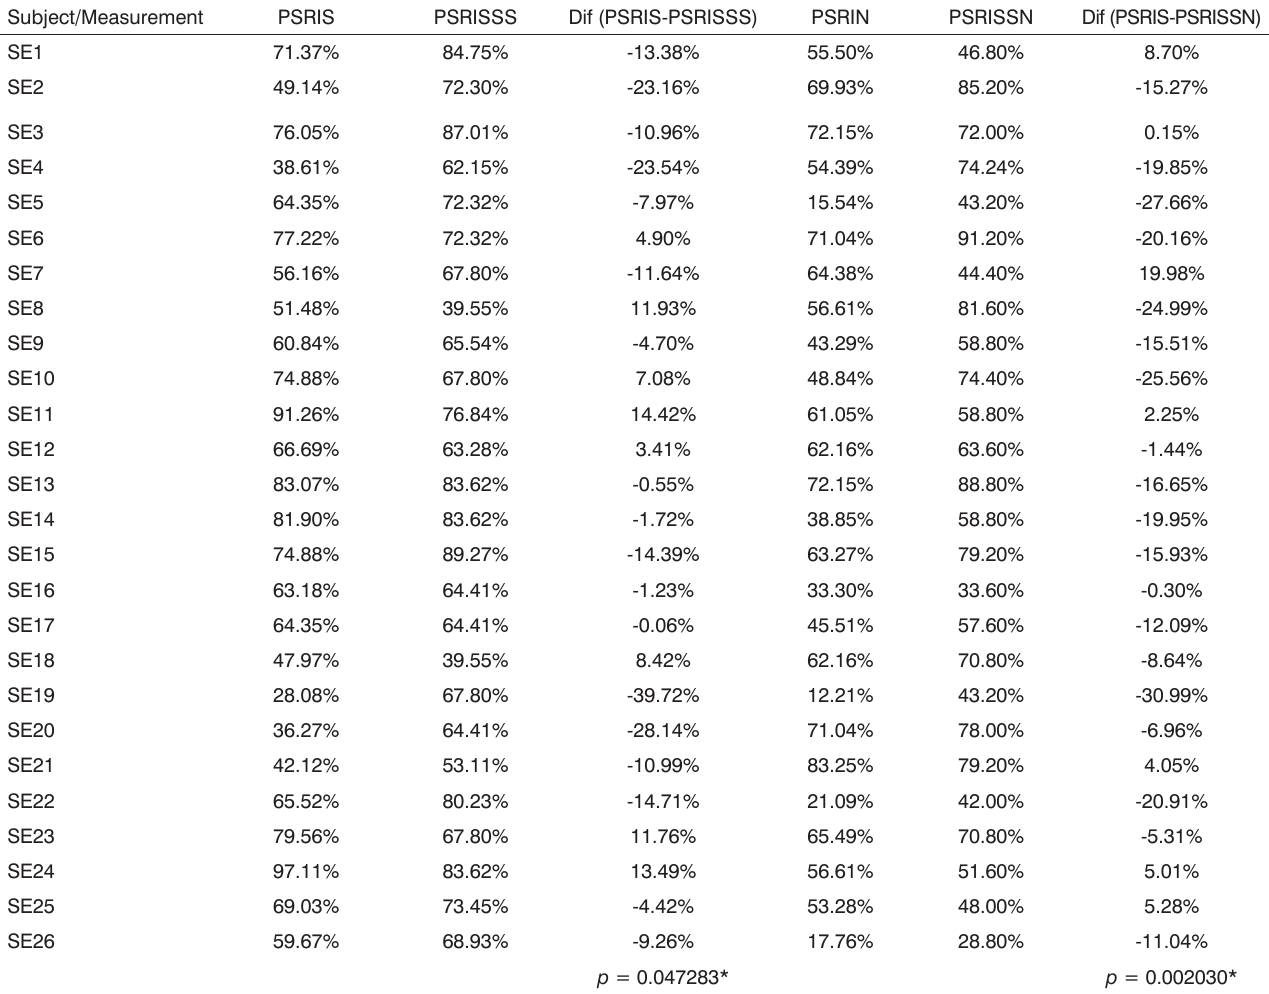
Table 2. Percent Sentence Recognition Indices and differences in performance on both tests of subjects in the case